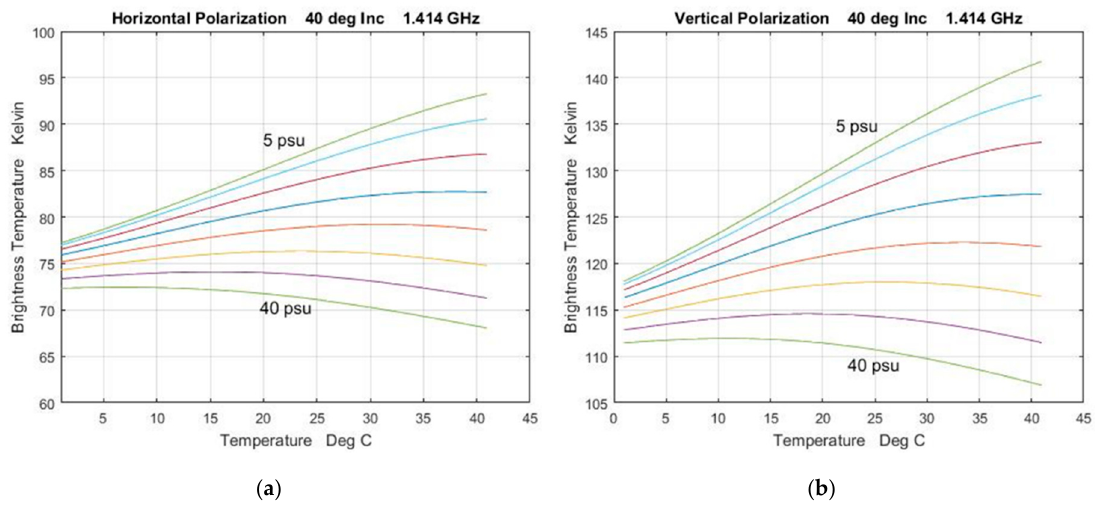
Figure 3. Brightness temperature as a function of SST for constant SSS. The calculations are for a flat surface (no wind) with a frequency of 1.413 GHz and 40 ° incidence angle. Horizontal polarization ( a ); Vertical polarization ( b ). The calculations use the Klein-Swift dielectric constant model function [19].